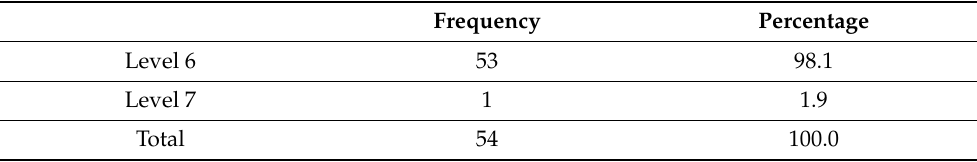
Table 3. Percentages for university